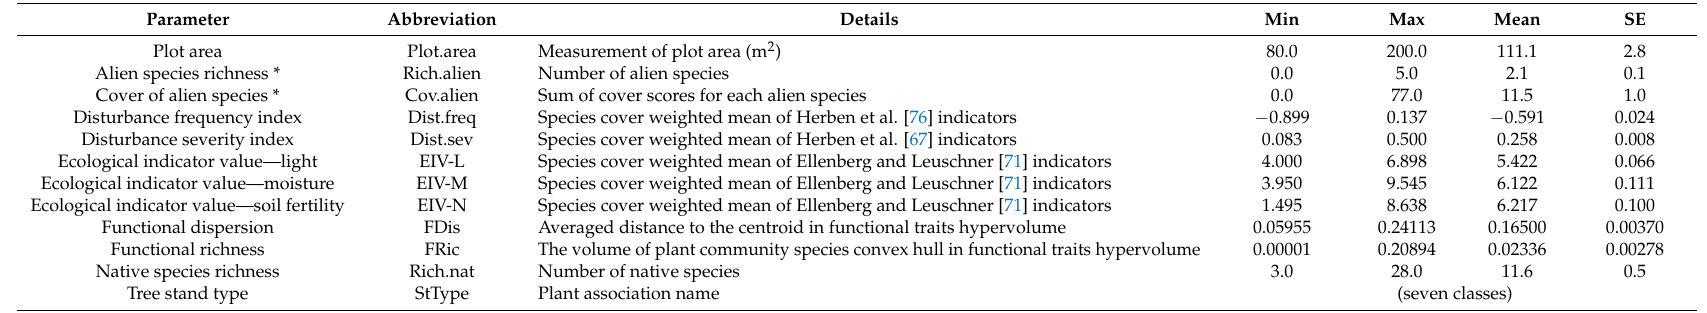
Table 3. Overview of parameters analyzed in the study. Parameters marked by an asterisk are dependent variables and others are